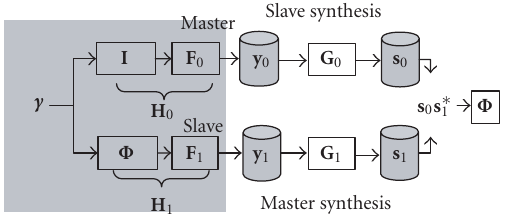
Figure 4: Forward model and linear estimate for 2-channel conven- tional SAR